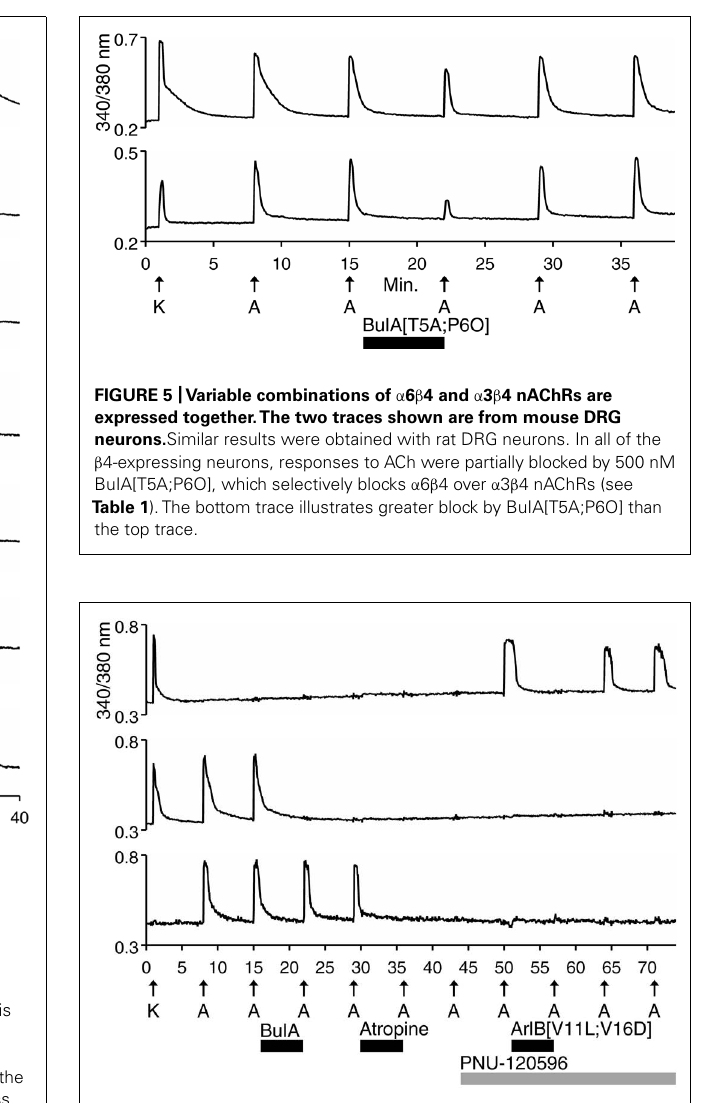
FIGURE 6 |A subset of non-neuronal DRG cells express muscarinic acetylcholine receptors (mAChRs). The three traces shown are from mouse DRG cells. Similar results were obtained with rat DRG cells.The bottom trace is from a non-neuronal DRG cell that did not respond to depolarization by 30 mM [K + ] o (K), but did respond to applications of 1 mM ACh. Notably, the ACh-elicited responses in this cell were not blocked by BuIA, but were blocked by 1 μ M atropine, an antagonist of mAChRs. In contrast to the bottom trace, the top two traces are from DRG neurons that responded to depolarization by 30 mM [K + ] o .The top trace is from the DRG neuronal subclass that expresses α 7 nAChRs and the middle trace is from the α 3 β 4/ α 6 β 4-expressing